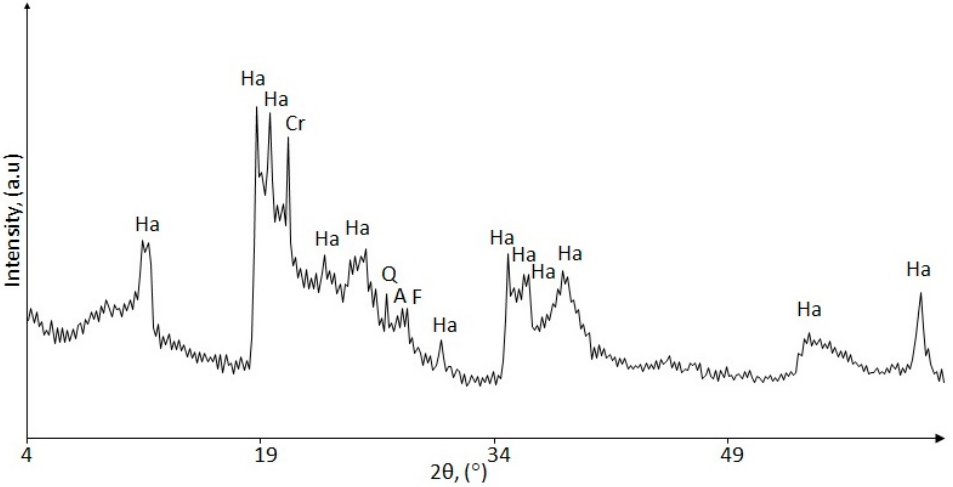
Figure 8. Sample XRD pattern containing high quantities of halloysite (Ha—Halloysite; Cr—Cristobalite; Q—Quartz).